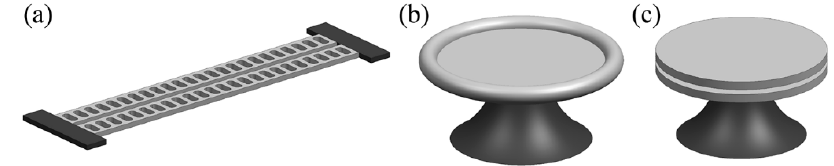
Figure 15. Schematic of ( a ) the coupled double clamped “zipper” cavities, ( b ) the toroid micro ring cavity and ( c ) the vertically stacked and coupled disk cavities.